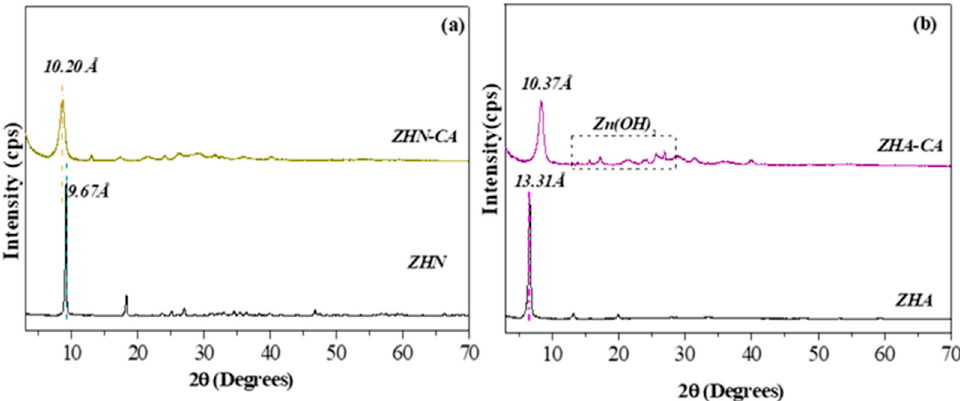
Figure 2. Powder X-Ray Diffraction patterns of ( a ) starting material and hybrid materials based on ZHN and ( b ) inorganic host matrix ZHA, and their intercalated compound with caffeinate anion.